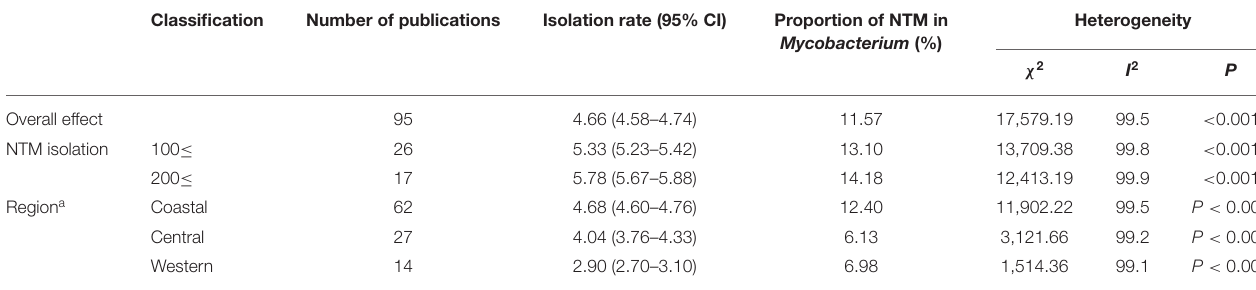
TABLE 1 | Non-tuberculous mycobacteria (NTM) isolation rates in mainland China and heterogeneity among studies included in the meta-analysis.